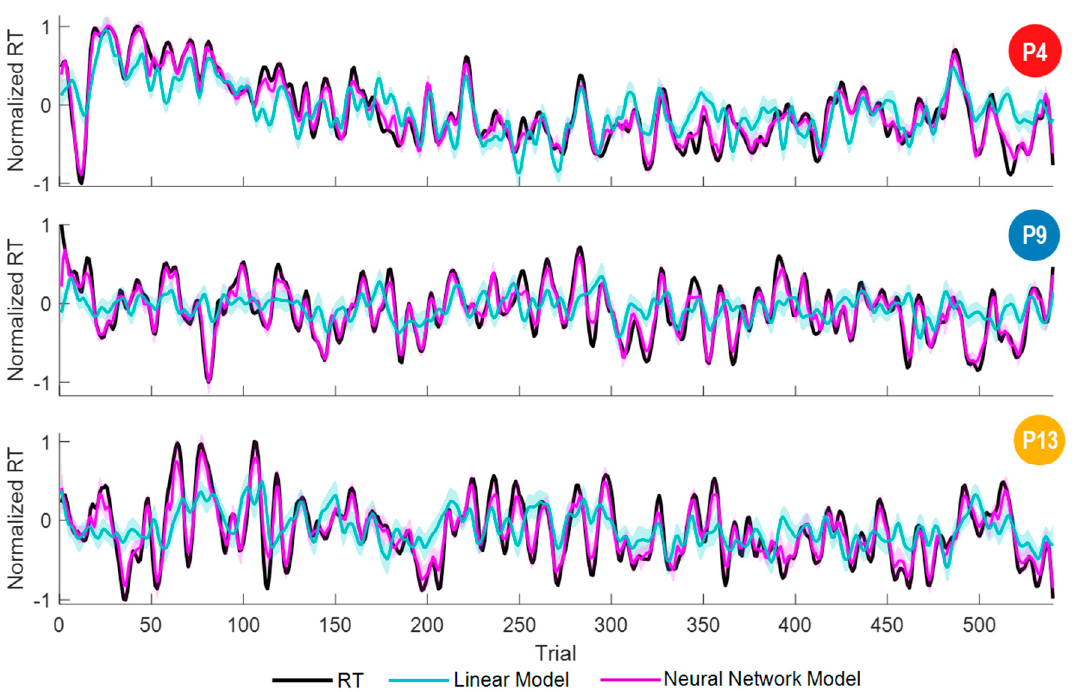
Figure 6. Predictions of each model are overlaid on top of the normalized RT for each of three representative participants: P4, P9, and P13.